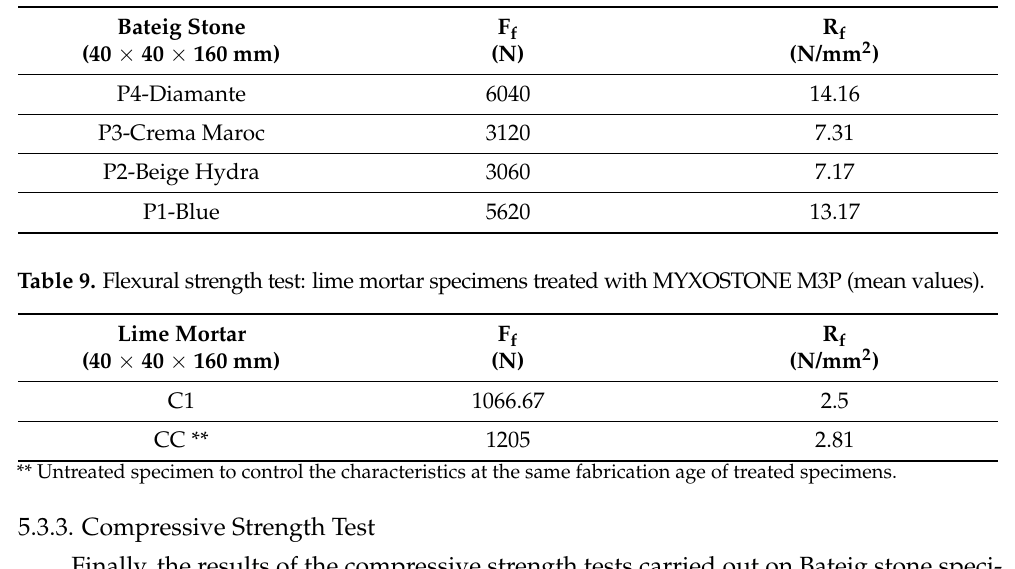
Table 8. Flexural strength test: Bateig stone specimens treated with MYXOSTONE M3P (mean values).